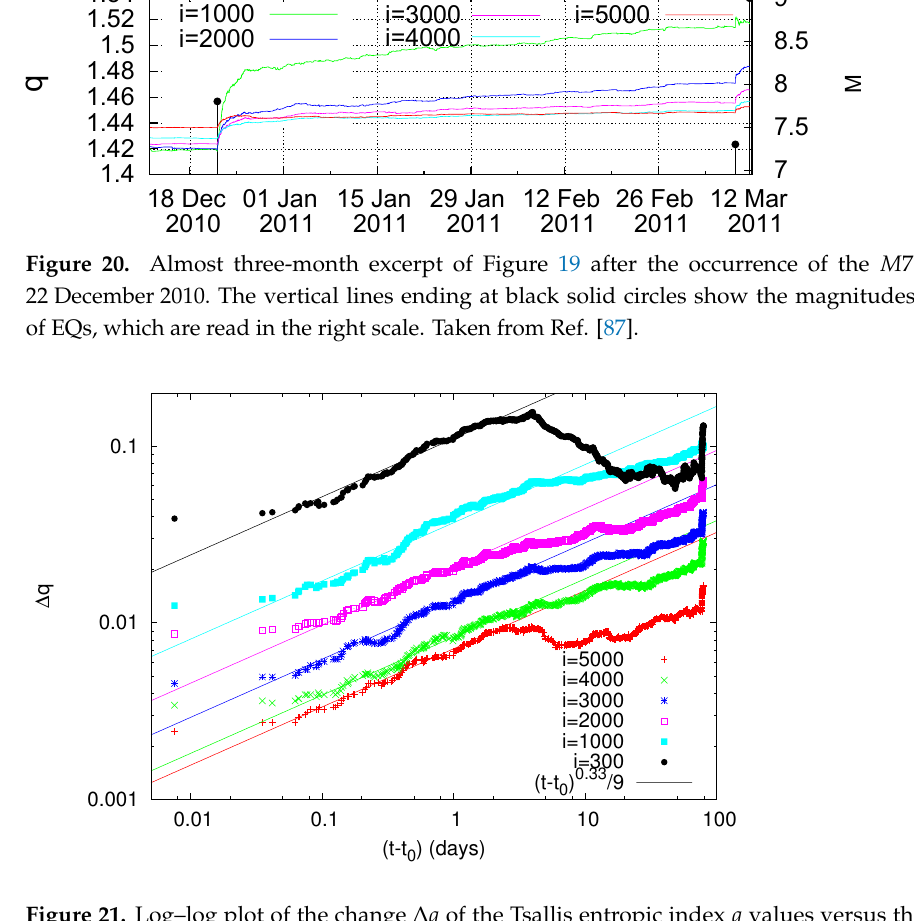
Figure 21. Log–log plot of the change ∆ q of the Tsallis entropic index q values versus the elapsed time ( t − t 0 ) in days since the establishment of scaling behavior after the occurrence of the M 7.8 EQ on 22 December 2010. The t 0 value is 0.2 days, measured from the M 7.8 EQ occurrence and c = 1/3. Taken from Ref.